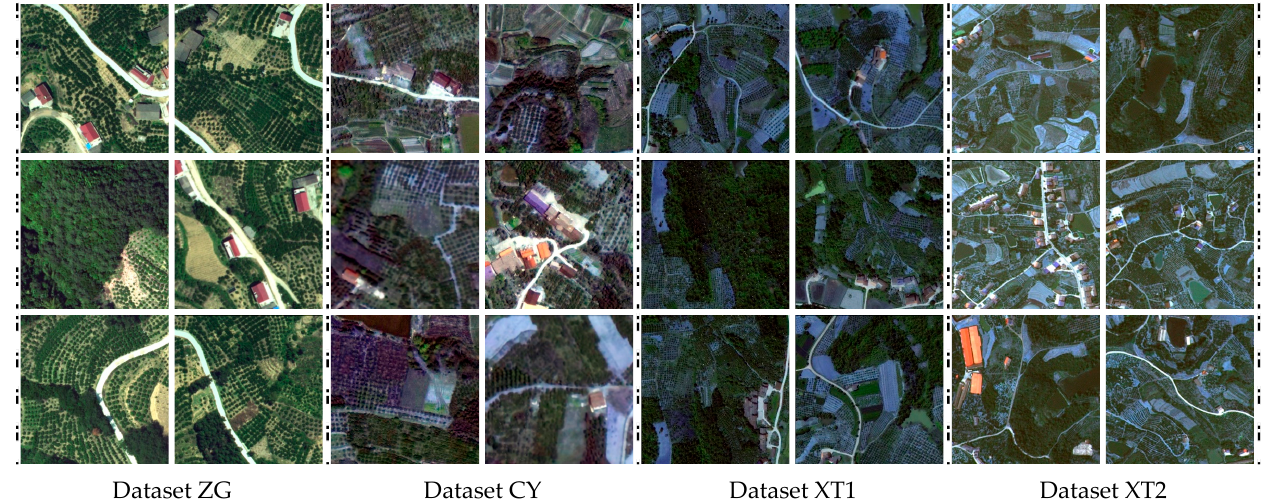
Figure 2. The figure displays the sample images from the four